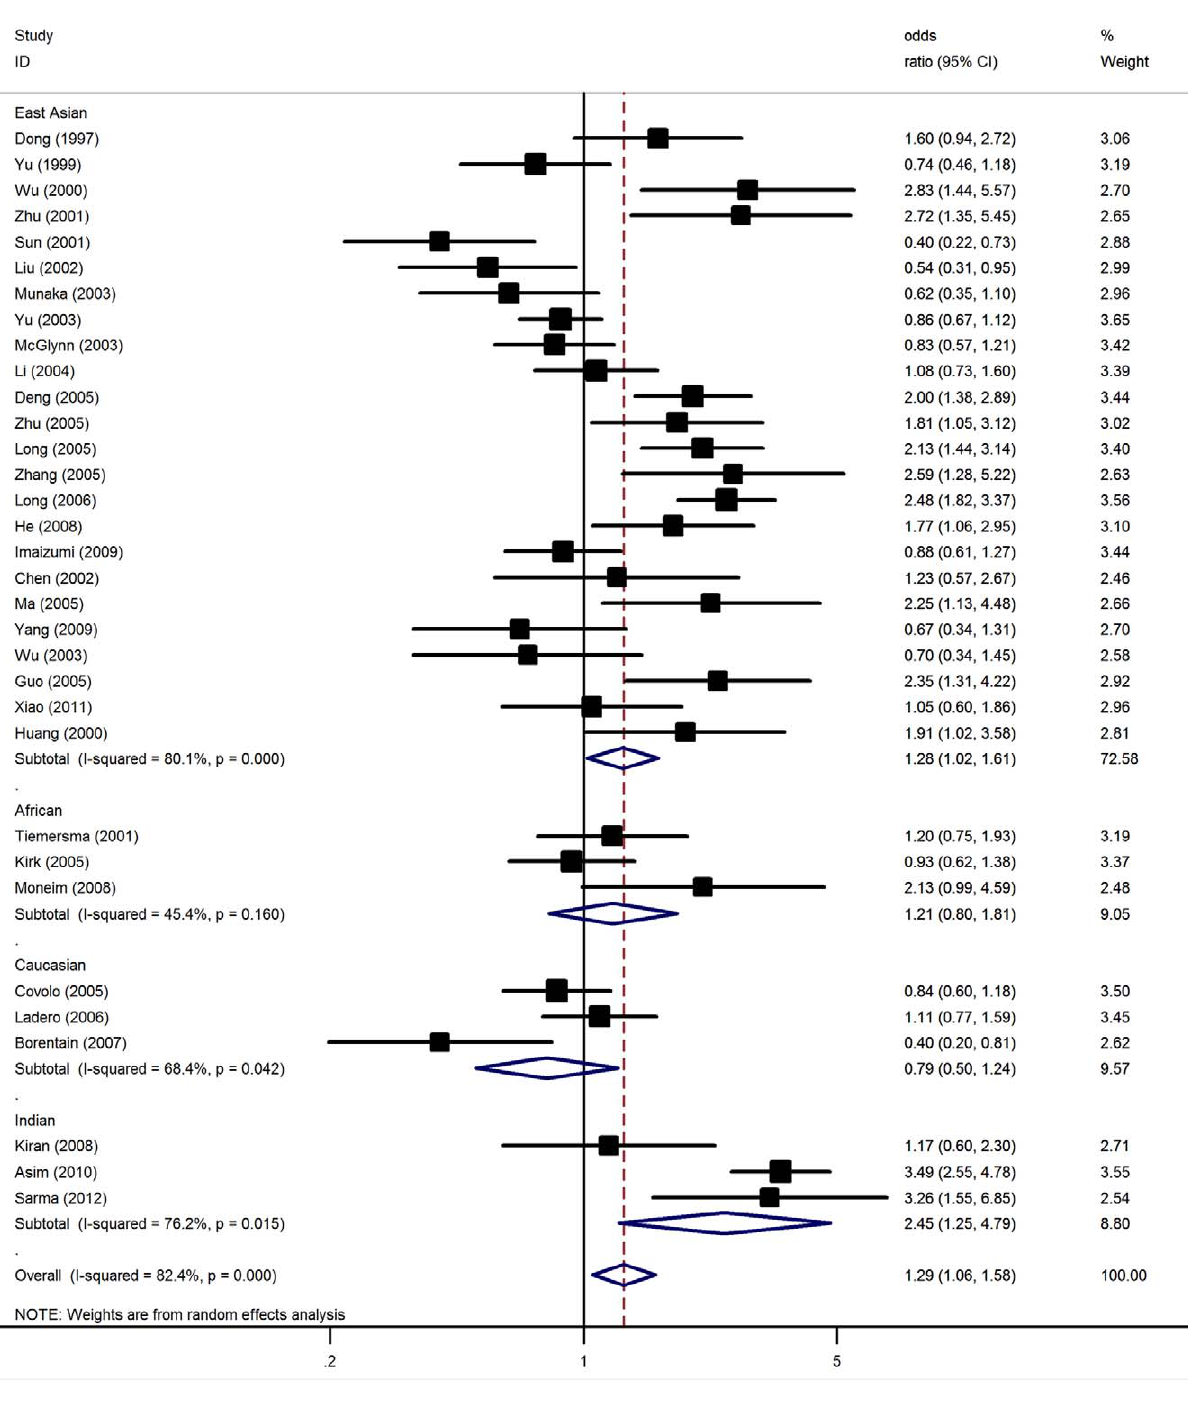
Figure 1. Meta-analysis of GSTM1 null genotype associated with HCC.